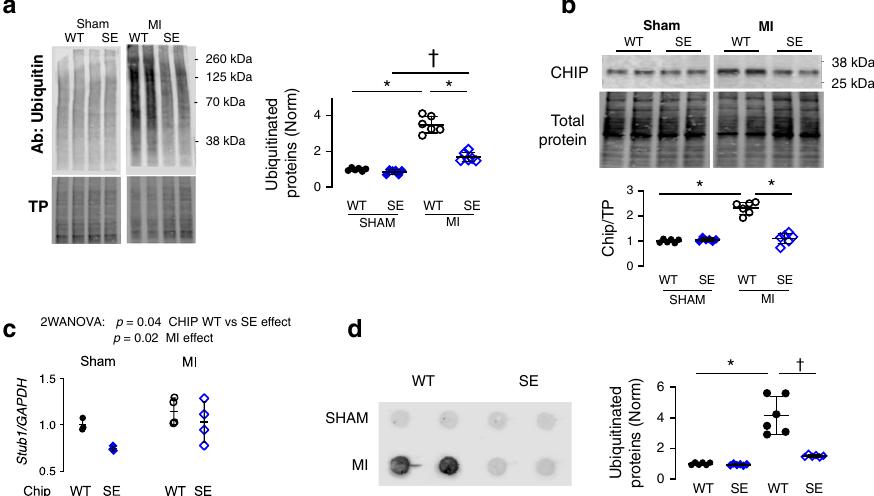
Fig. 9 Protein ubiquitination is reduced post MI in CHIP S20E mice. a Example protein ubiquitination gel and total protein (TP) loading gel from CHIP S20E and littermate controls (WT) after Sham or MI intervention. Summary results: n = 6 biological replicates, 2WANOVA; interaction term p = 4 × 10 − 7 , Tukey CHIP S20E mice. Summary: 6 biological replicates, 2WANOVA, Tukey mct: * p ≤ 5 × 10 − 10 . c CHIP gene expression ( Stub1/Gapdh ) same study measured in Sham and post MI mice. 2WANOVA results provided in fi gure. d Filter trap assay for insoluble proteins probed for ubiquitin which are increased after MI in WT but maintained at low levels in CHIP S20E myocardium. N = 6 biological replicates, 2WANOVA, Tukey mct: * p = 12 × 10 − 7 , † p = 1.9 × 10 − 6 . Source data are provided as a Source Data fi le. Individual data and mean ± SD shown in each summary